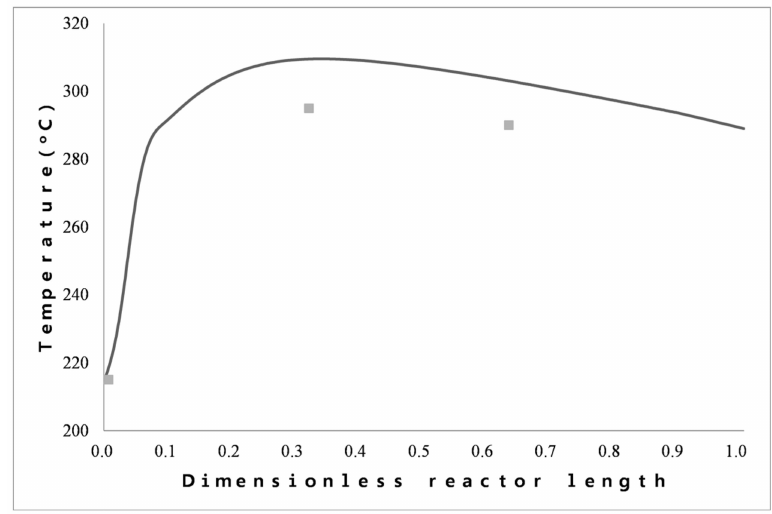
Figure 2. Simulated temperature profile and experimental data along the reactor length.